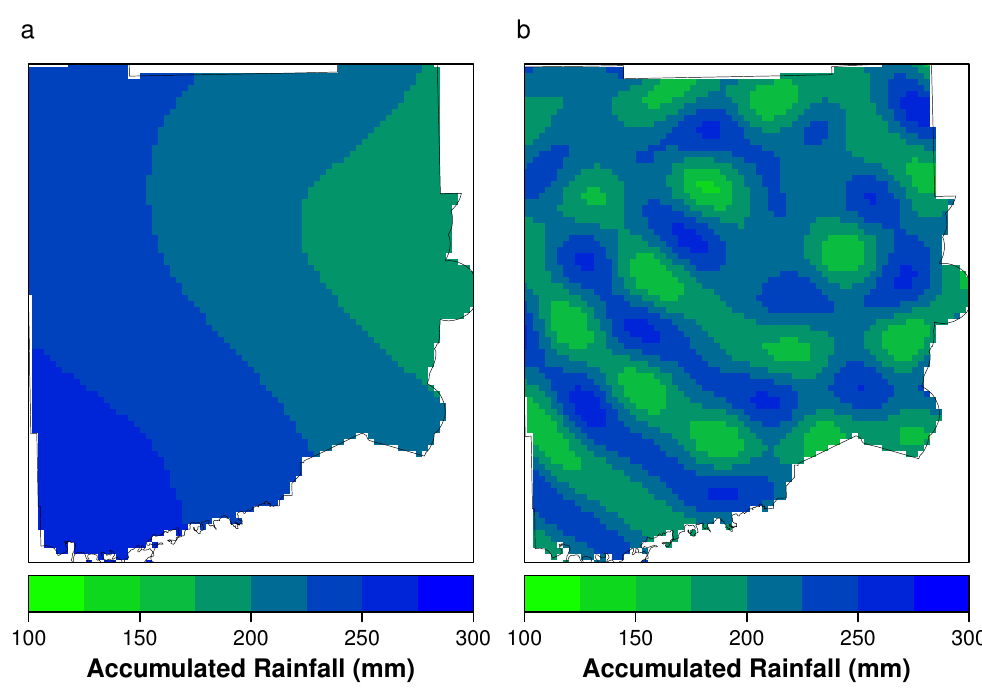
Figure 13. Interpolated rainfall map for Miami, Florida during Hurricane Irma 2017. ( a ) Kriging model with Bessel variogram. ( b ) Kriging model with Periodic